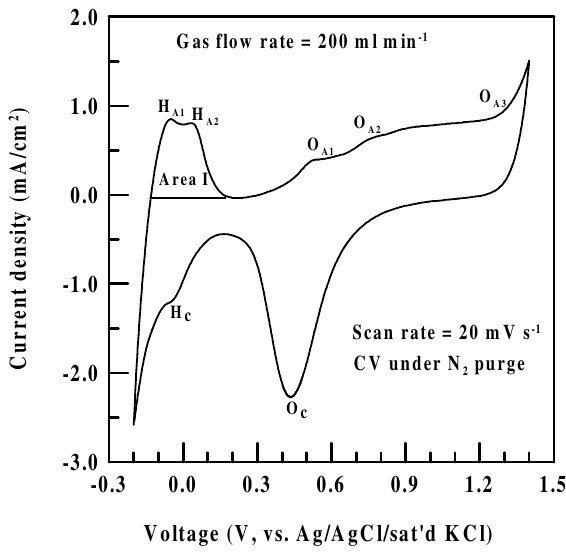
Figure 2 . Typical cyclic voltammogram (CV or the potentiodynamic current-potential profile) for a Pt/Nafion (cid:226) electrode run in pure N maintained at 200